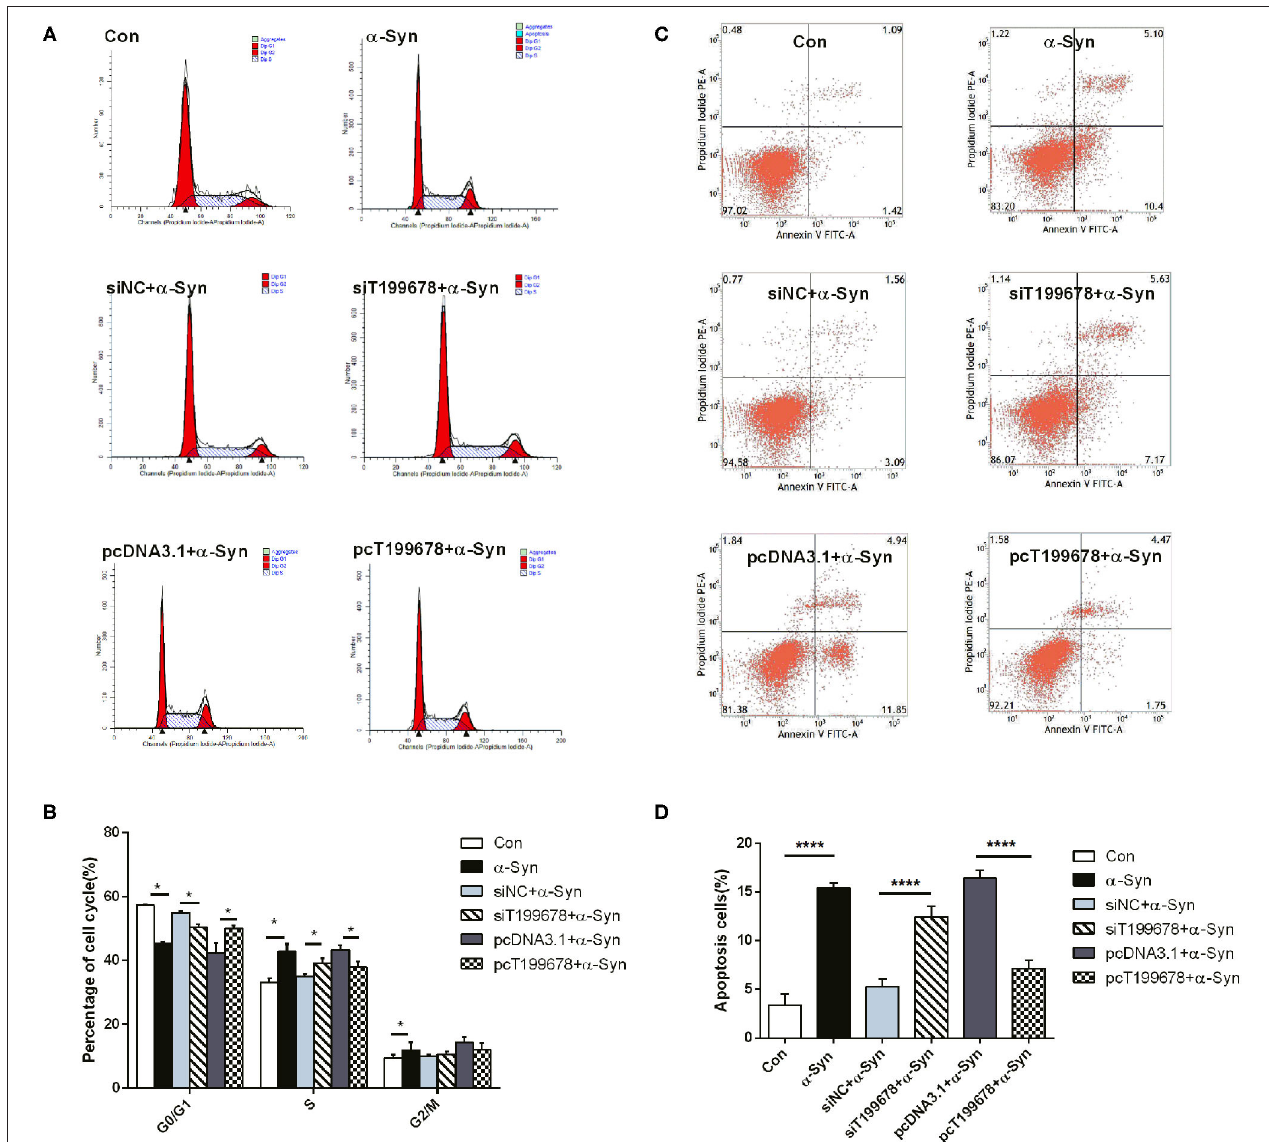
FIGURE 3 | lncRNA-T199678 mitigated α -Syn-induced cell cycle abnormality and apoptosis. SH-SY5Y cells were divided into six groups: control (wild type), α -Syn, siNC + α -Syn, siT199678 + α -Syn, pcDNA3.1 + α -Syn, and pc T199678 + α -Syn. (A,B) The proportion of cells in the G0/G1, S, and G2/M phases in cell cycle via flow cytometry (both in the G0/G1 phase and S phase, one-way ANOVA, P < 0.01, followed by Tukey’s multiple-comparison tests: Control vs. α -Syn, * P < 0.05; siNC + α -Syn vs. si T199678 + α -Syn, * P < 0.05; pcDNA3.1 + α -Syn vs. pc T199678 + α -Syn, * P < 0.05). (C,D) Percentage of apoptotic cells was quantified using flow cytometry (one-way ANOVA, F = 115.3, df = 17, P < 0.0001, followed by Tukey’s multiple-comparison tests: control vs. α -Syn, **** P < 0.0001; siNC + α -Syn vs. siT199678 + α -Syn, **** P < 0.0001; pcDNA3.1 + α -Syn vs. pc T199678 + α -Syn, **** P < 0.0001).